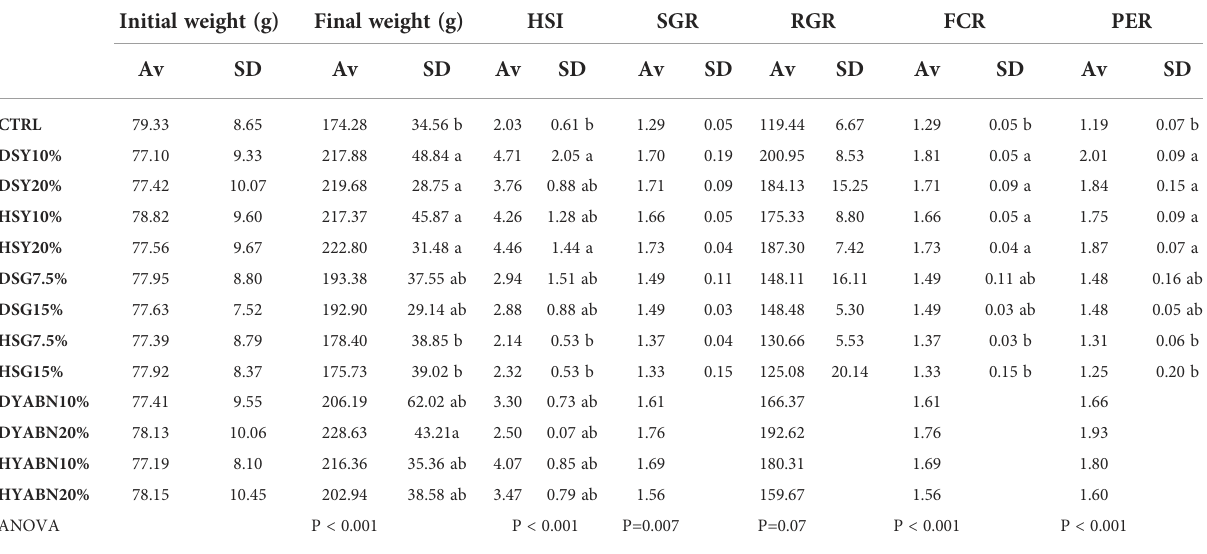
TABLE 3 Initial and fi nal weight of rainbow trout used in the inclusion trial (n = 60 per treatment) and results in hepatosomatic index (HSI; fi ve fi sh per tank, n = 3), speci fi c growth rate (SGR; n = 3), relative growth rate (RGR; n = 3), feed conversion ratio (FCR; n = 3), and protein ef fi ciency ratio (PER; n =